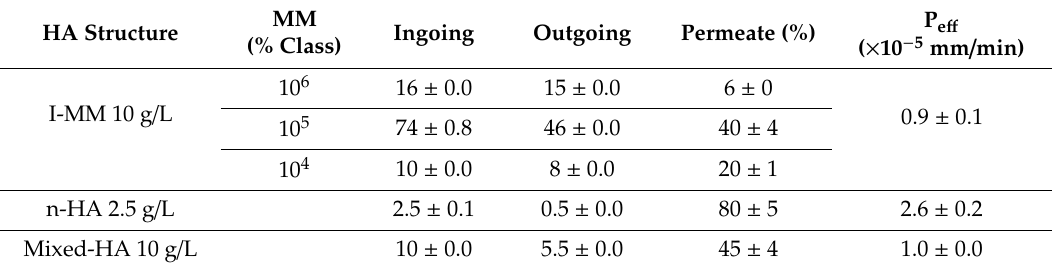
Table 3. Ingoing and outgoing concentrations, permeate and permeability coe ffi cient (P e ff ) as function of HA structures.